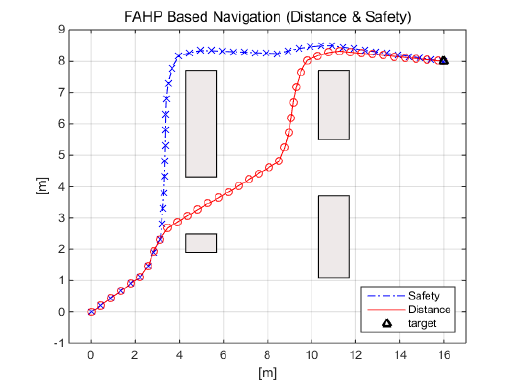
Figure 5. Comparison between short-distance and high-safety RM-based AHP path